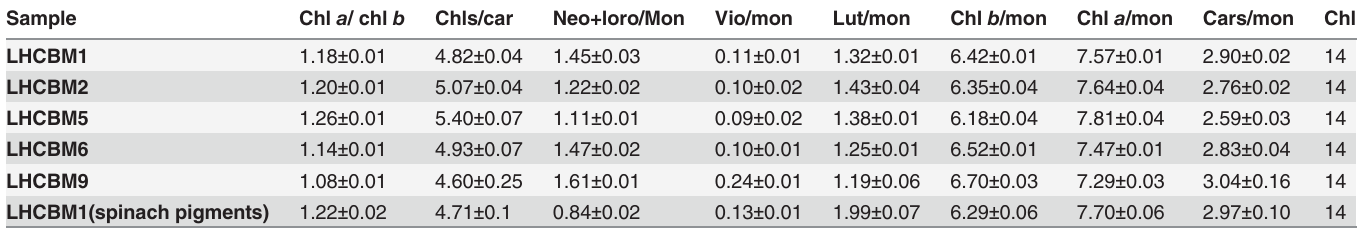
Table 4. Pigment composition of the LHCBM reconstituted proteins in vitro .